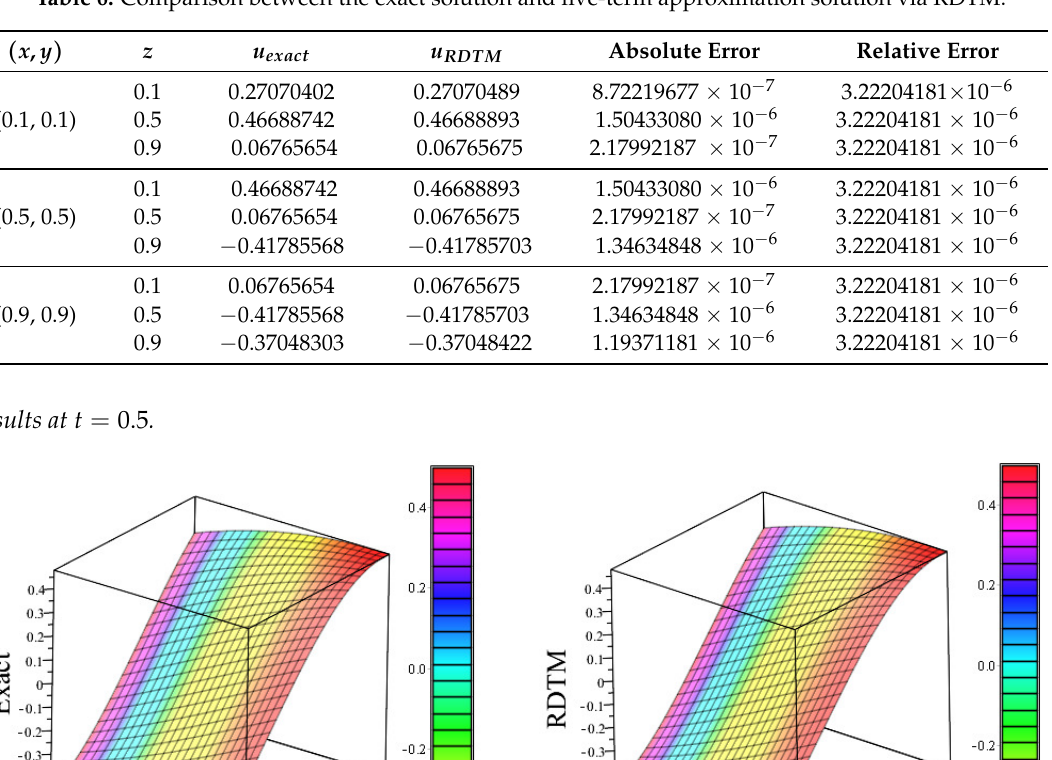
Table 6. Comparison between the exact solution and five-term approximation solution via RDTM.